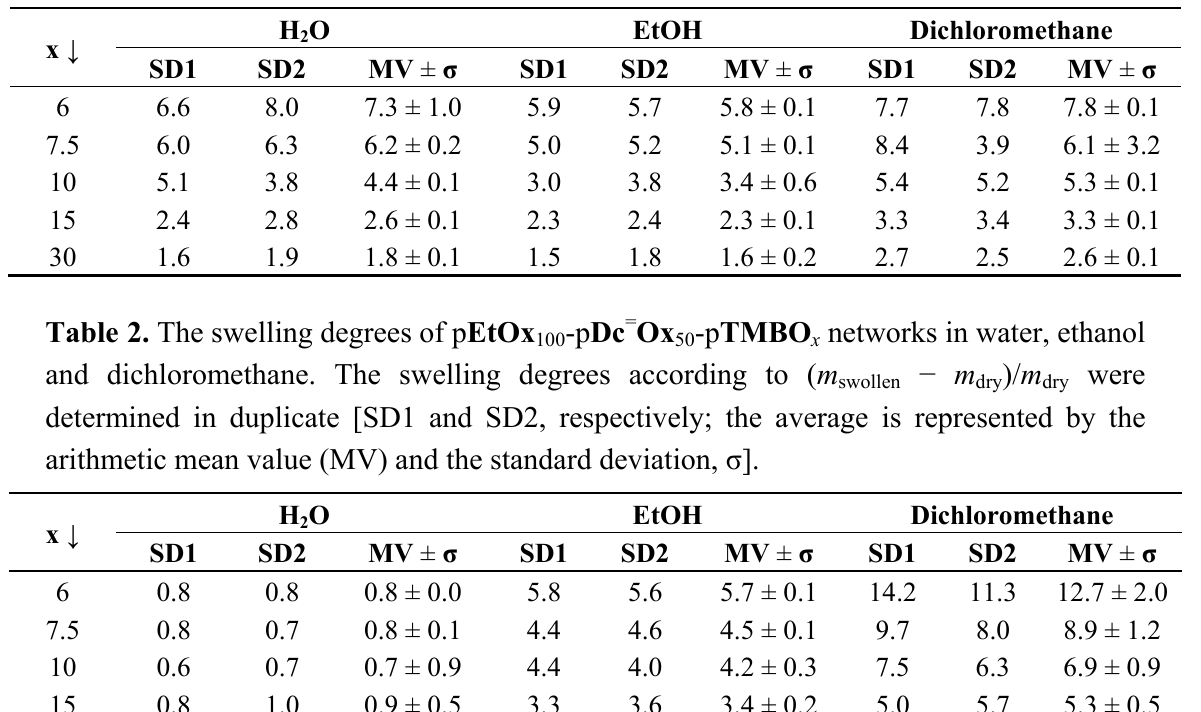
Table 1. The swelling degrees of p EtOx dichloromethane. The swelling degrees according to ( m in duplicate [SD1 and SD2, respectively; the average is represented by the arithmetic mean value (MV) and the standard deviation, σ ].